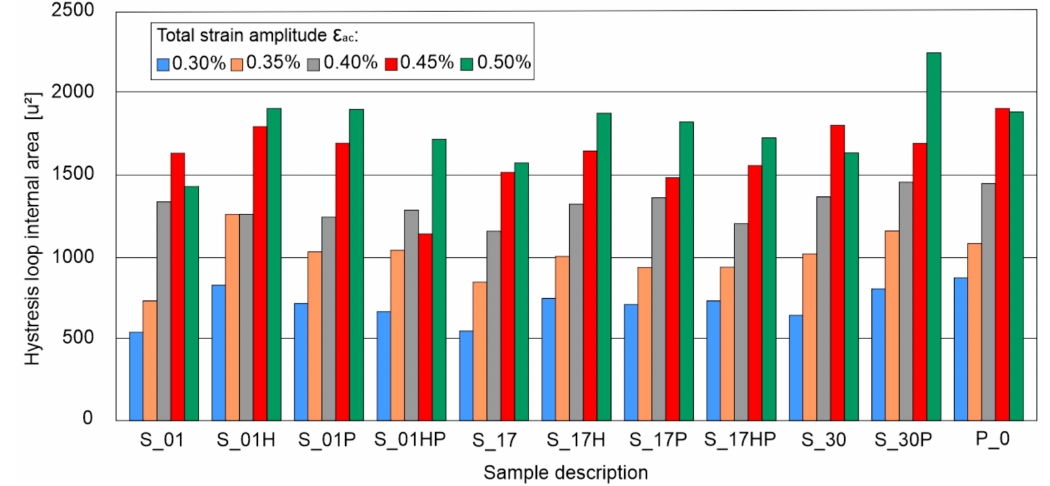
Figure 6. Registered areas of mid-life hysteresis loops (in square